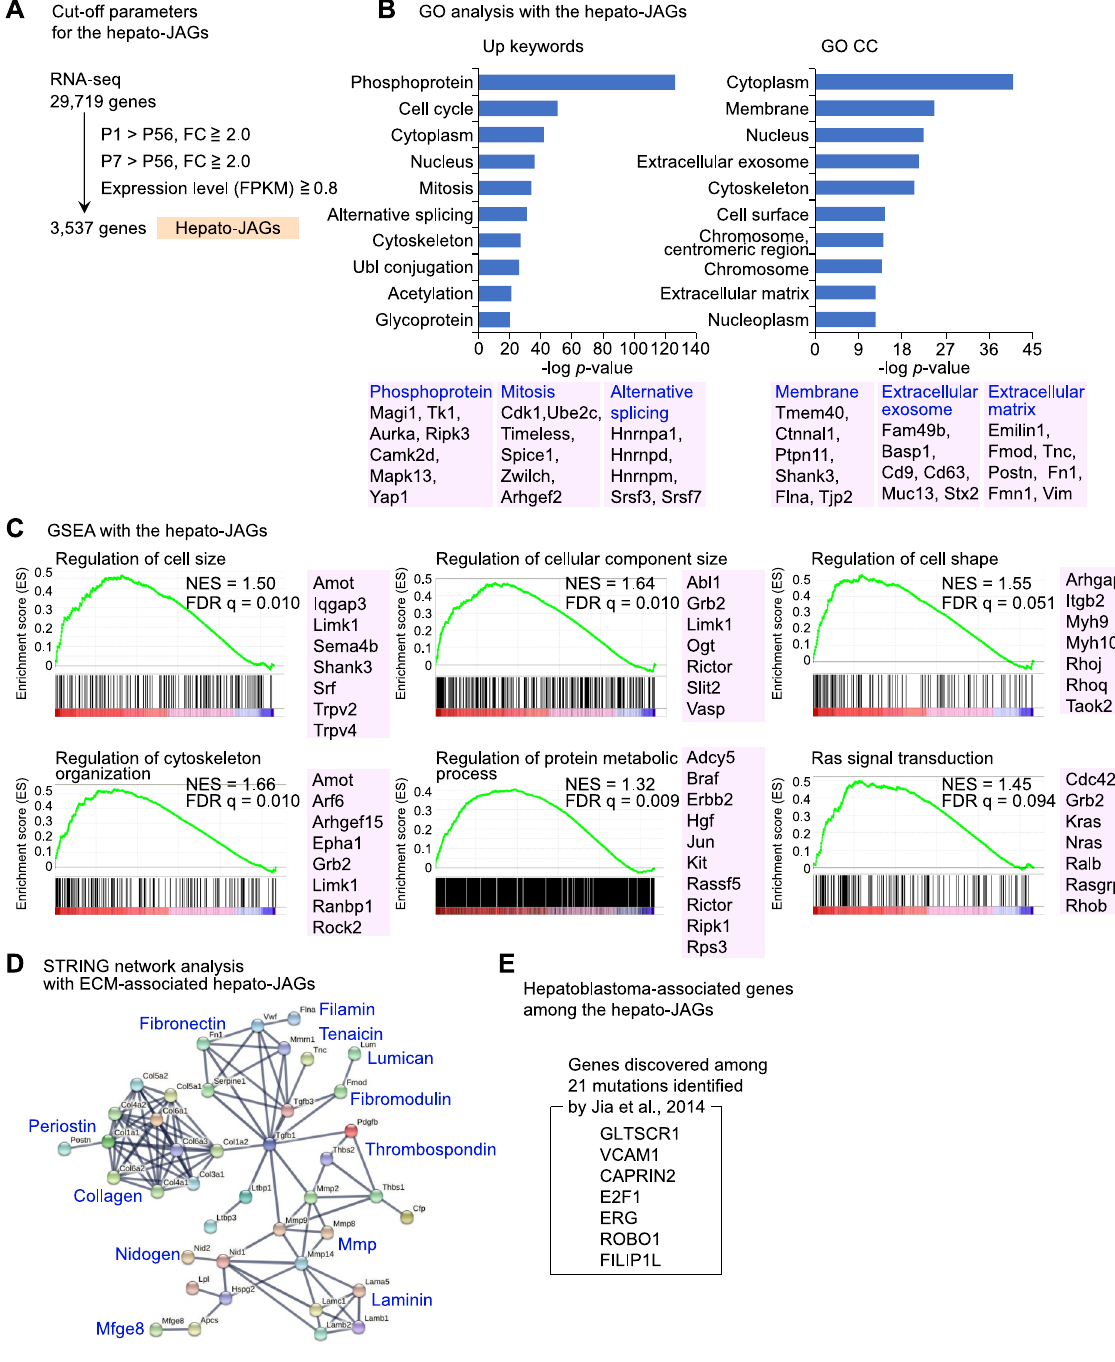
Figure 2. The hepato-JAGs exhibit a distinct gene expression profile. ( A ) Filtration and identification of hepato-JAGs from the comprehensive transcriptome analysis in the hepatocytes of the differently-aged mice. ( B ) The gene ontology (GO) analysis with the hepato-JAGs. GO CC, gene ontology cellular component. Ubl, ubiquitin and ubiquitin-like. ( C ) The gene set enrichment analysis (GSEA) with the transcriptome in the hepatocytes. NES, normalized enrichment score. FDR, false discovery rate. ( D ) The STRING network analysis with the extracellular matrix (ECM)-associated hepato-JAGs. ( E ) The hepato-JAGs discovered among the genes reported by Jia et al. to be causative for the